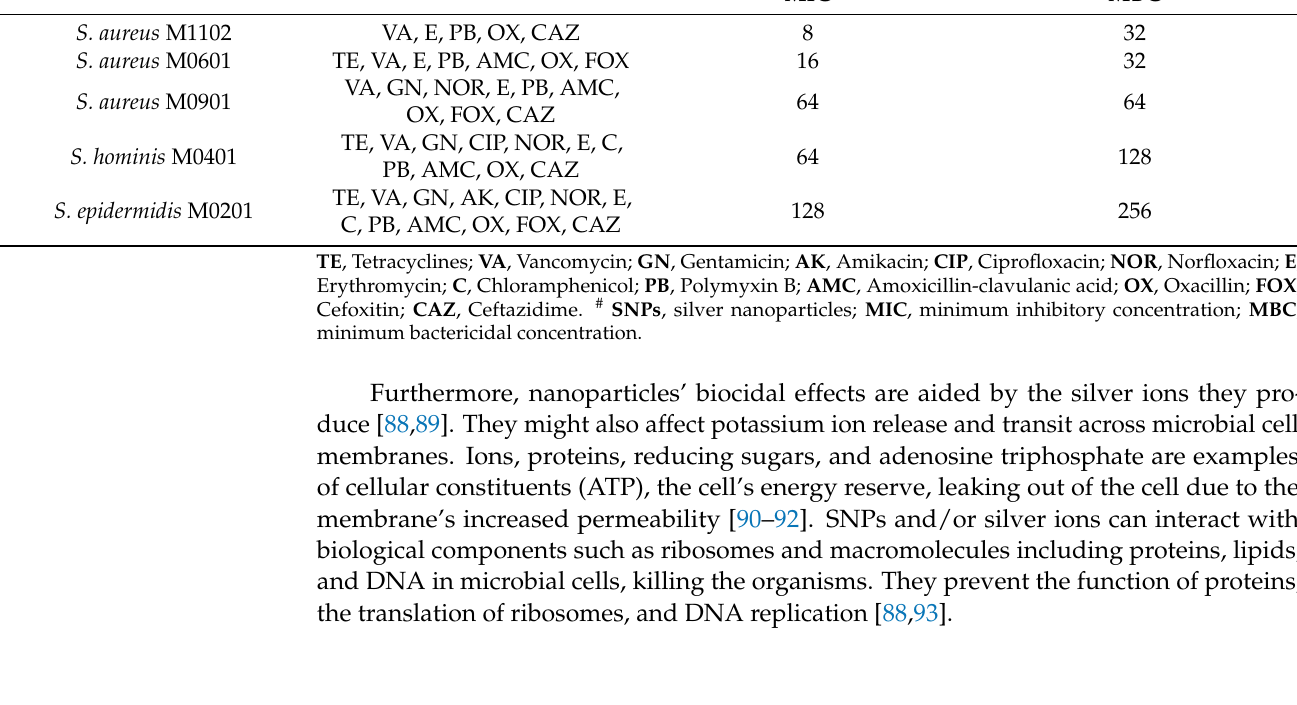
Table 2. Antimicrobial activity of the SNPs against periodontal pathogenic strains. Periodontal Pathogens Antibiotic Resistance